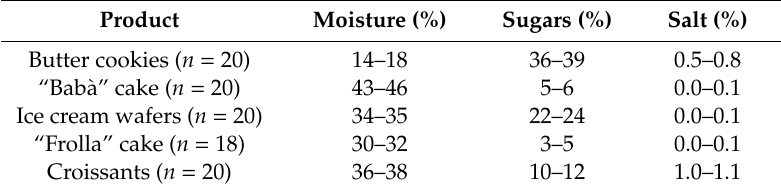
Table 3. Moisture, sugar, and salt percentage in each product of sweets category.